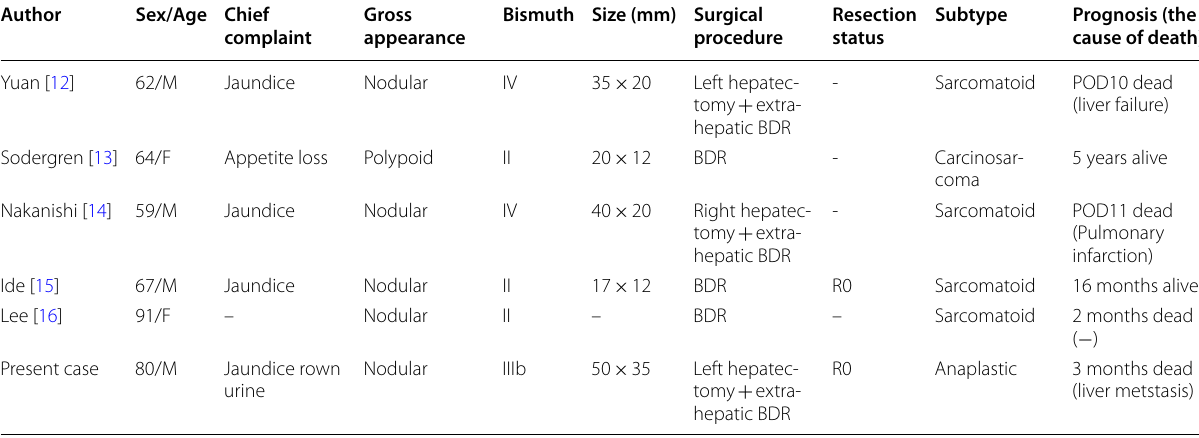
Table 1 Patient characteristics with undifferentiated carcinoma of the hepatic